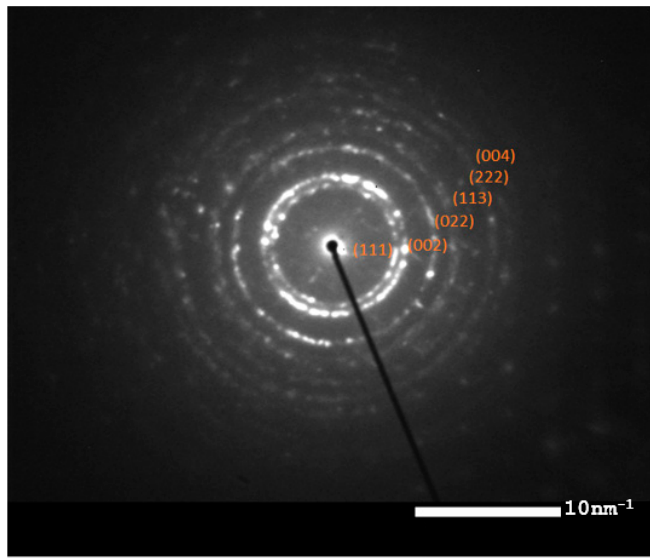
Figure 7. TEM image for HfCN coatings.